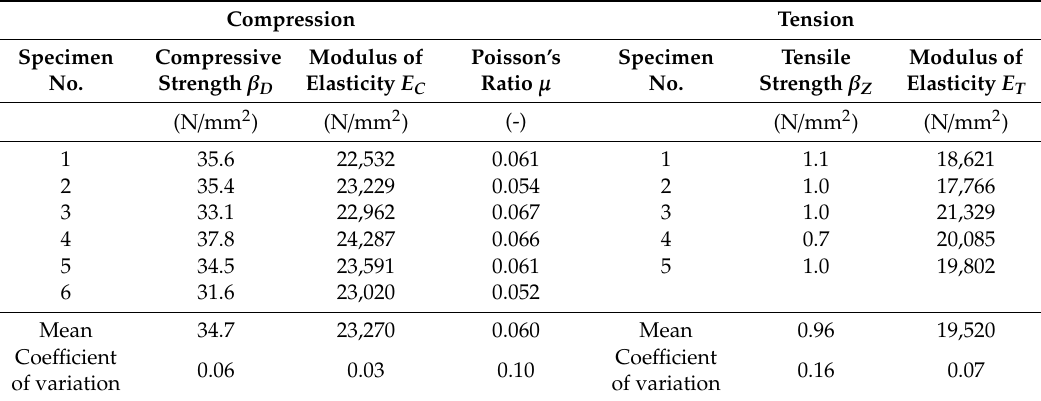
Table A2. Static modulus of elasticity of grouting mortar under compression as well as compressive strength and Poisson’s ratio (after